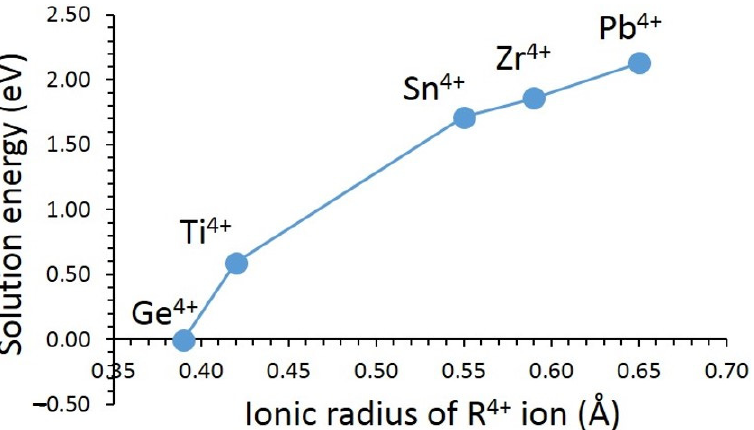
Figure 6. Solution energies of tetravalent dopants on the Si site.